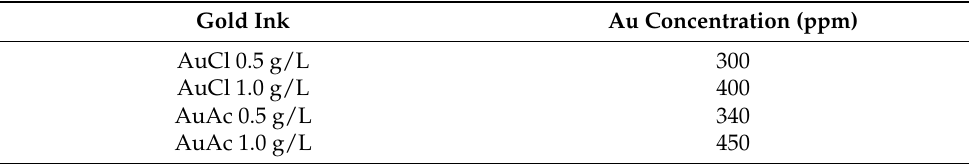
Table 1. Au concentration in the prepared gold